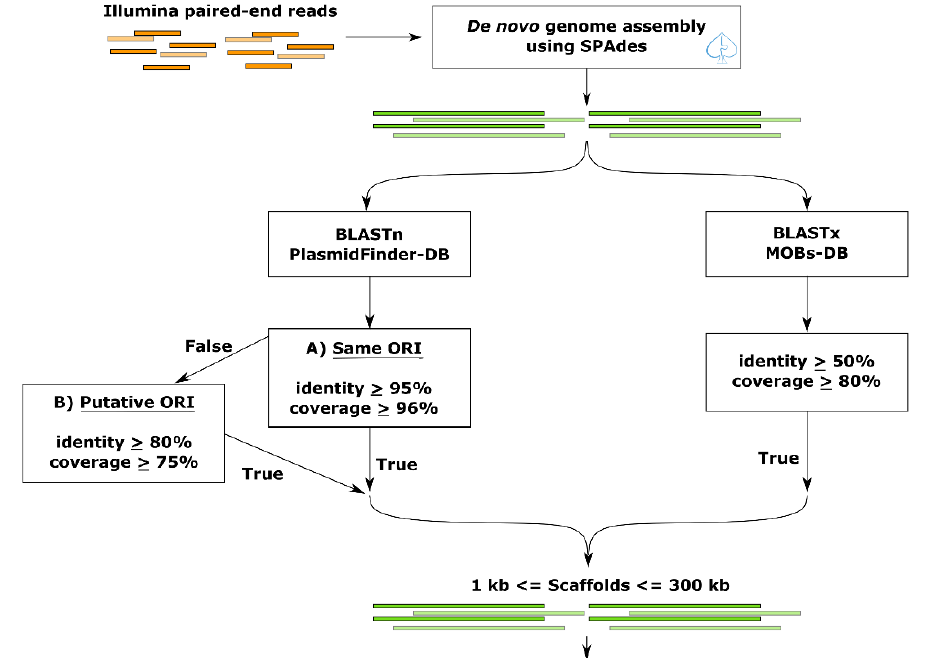
Figure 1. Plasmid-Gather workflow. First, MiSeq Illumina paired-end reads were trimmed using Trimmomatic (version 0.36) [17] and assembled by SPAdes (version 3.10.1) [18]. BLAST analysis